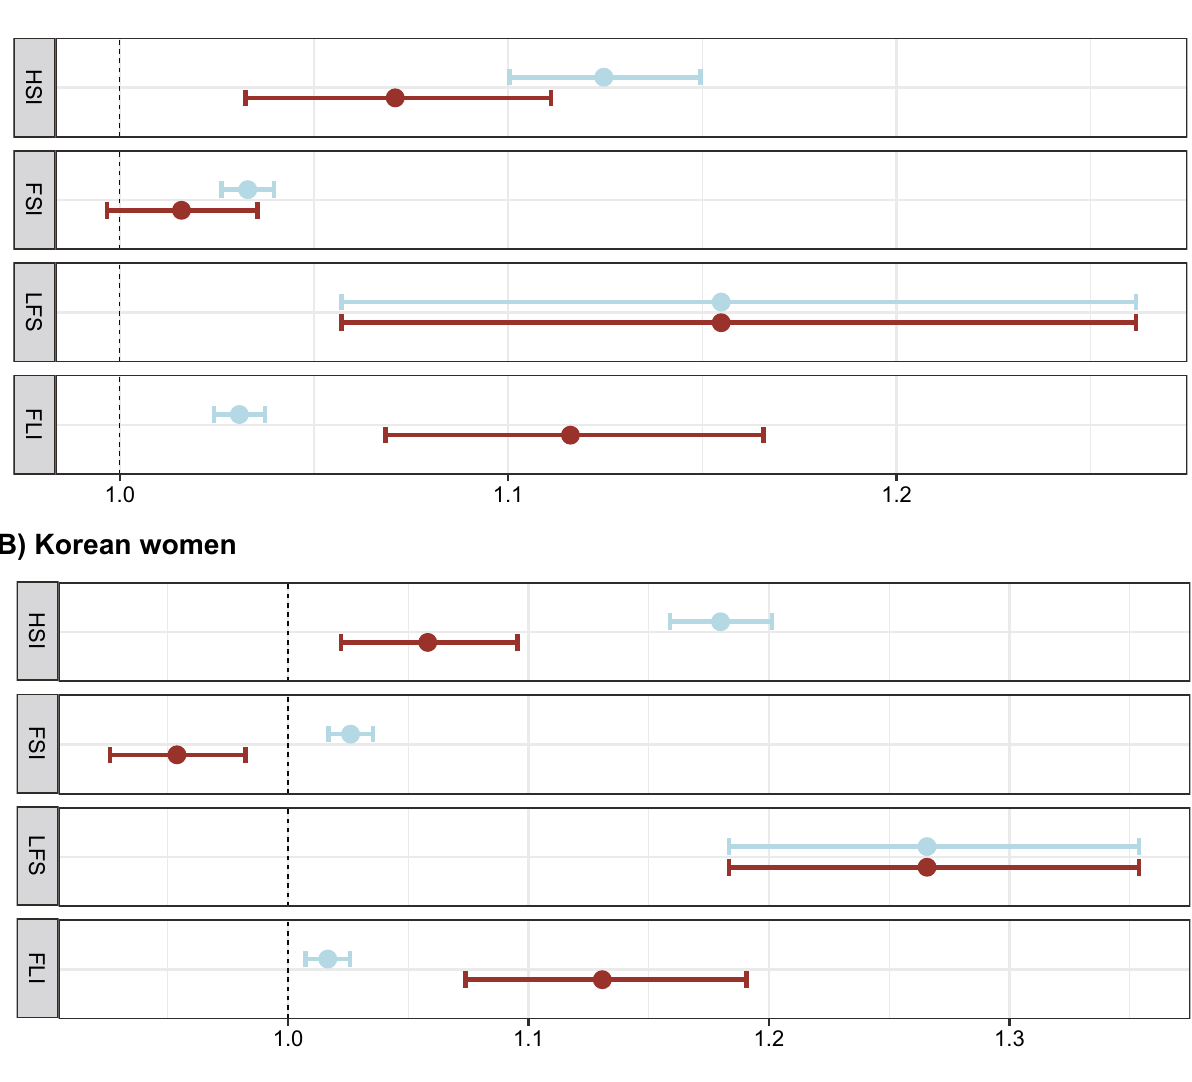
Figure 4. Relationships between LSMI and four hepatic steatosis indices. LSMI status (presence vs. absence) and four indices in Korean men ( A ) and women ( B ) were used as dependent and independent variables, respectively. X-axes indicate odds ratio and 95% confidence interval calculated by multivariate logistic regression models, which include age, physical activity, current smoking, daily protein intake, hypertension, type 2 diabetes, dyslipidemia, CVD, systolic blood pressure, serum fasting glucose, total cholesterol, and serum creatinine as covariates. Brown points and lines indicate that the analysis was conducted using indices for fatty liver with a zero value of BMI coefficient. LSMI low skeletal muscle index, BMI body mass index, HSI hepatic steatosis index, FSI Framingham steatosis index, LFS NAFLD liver fat score, FLI fatty liver